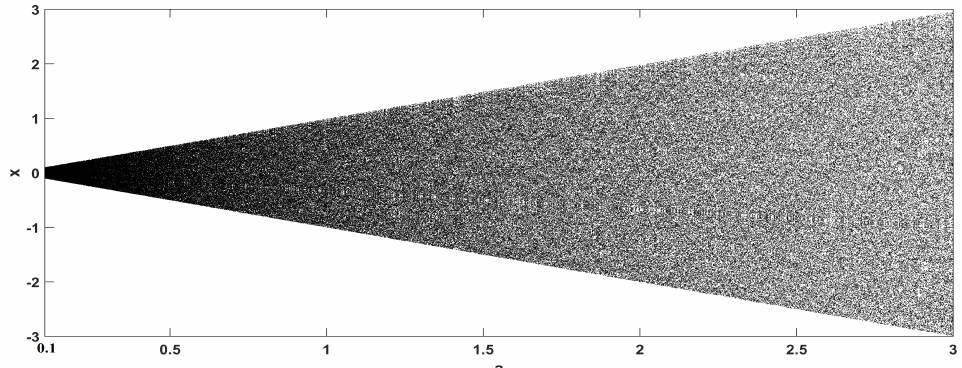
Figure 4. LE diagram with respect to parameter r , for a = 1, b = 1.99.